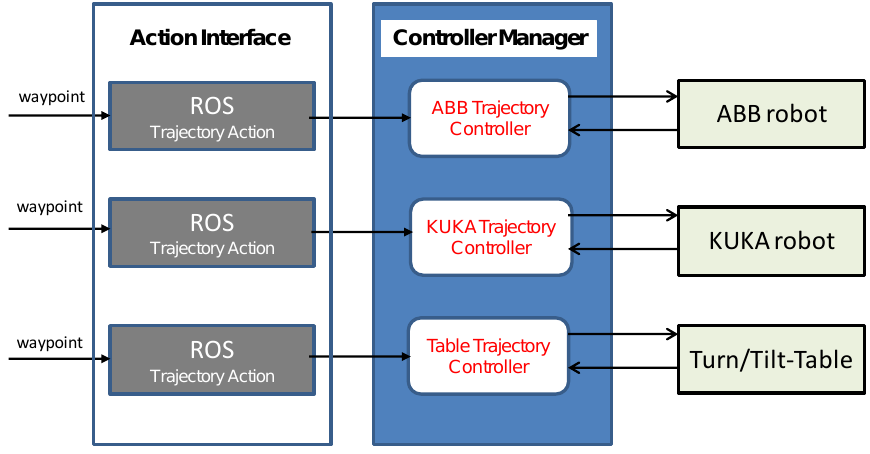
Figure 9. GAZEBO-ROS/MoveIt! controller infrastructure.